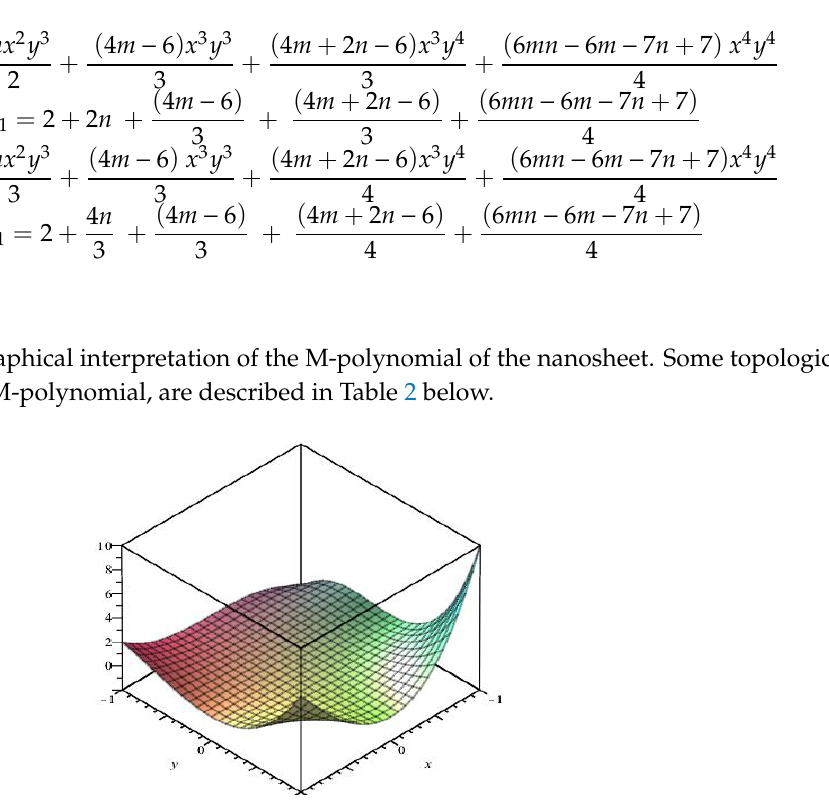
Figure 2. The graph of M-polynomial of coordination nanosheet. Table 2. The relation between topological indices and